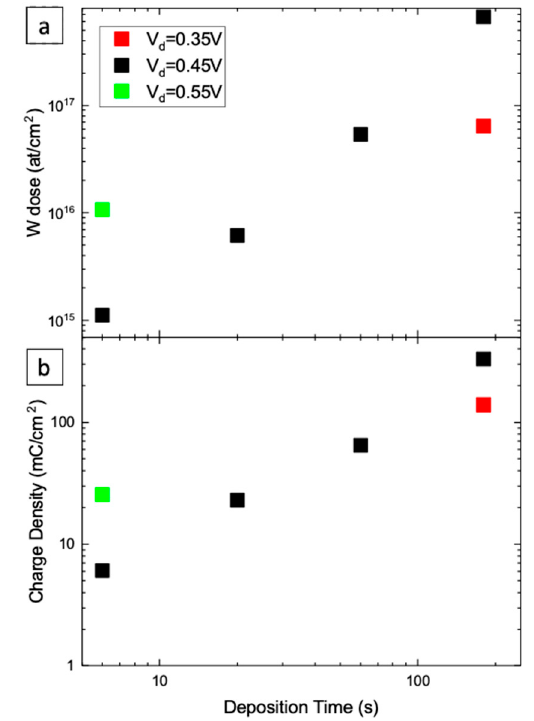
Figure 8. Rutherford backscattering spectrometry (RBS) spectra of electrodeposited WO 3 . The normal configuration is used for the determination of W dose from the integration of the peak related to the W presence for the sample deposited by using V d = 0.45 V for 1 min; Inset: W peak of samples deposited by using V d = 0.45 V for 6 s, 20 s and 1 min.